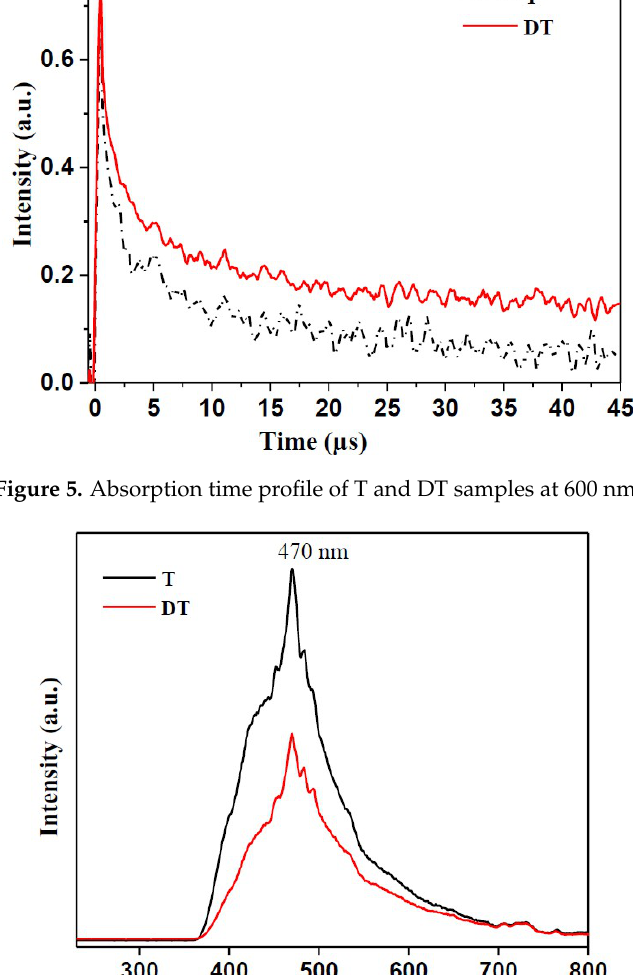
Figure 7. Reusability and photocatalytic efficiency of the DT aqueous solution for reduction of o- dinitrobenzene to corresponding o-phenylenediamine under solar simulated light irradiation after 24 h, reaction conditions: 25 mg DT sample, 50 µmol o-dinitrobenzene, 250 µmol oxalic acid, 5 cm3 deionized water, Ar Experimental section. 2.2. Materials and Chemicals The triblock copolymer surfactant poly (ethylene glycol)-poly (propylene glycol)- poly (ethylene glycol) (P-123, M wt. ~5800), titanium tert-butoxide Ti(OC(CH 3 ) 3 ) 4 (TBOT), thiourea (≥99%), Triton-X 100, polyethylene glycol (10,000 MW), sodium sulfate (>99%), oxalic acid dihydrate (≥99%), dichloromethane (High-performance liquid chromatography (HPLC) grade, >99.9%), ethanol (99.8%), o-dinitrobenzene (≥99%), o-nitroaniline (98%) and o-phenylene diamine (99%) were purchased from Sigma-Aldrich, Darmstadt, Germany and were used as received.